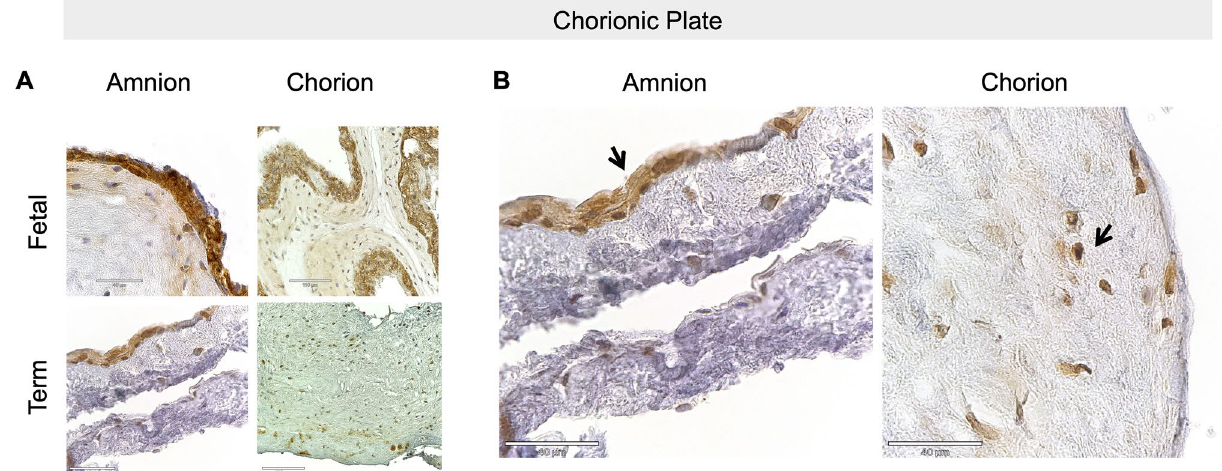
Figure 3. Fetal membranes contain RNLS. (A) RNLS labeling in amnion and chorion of the chorionic plate throughout development during fetal and term-time points. (B) Representative amnion and chorion RNLS staining with arrows pointing to regions of RNLS staining. Immunohistochemistry with hematoxylin staining for RNLS using m28-RNLS antibody at 20x (A) and 60x (B) . Black arrow pointing at RNLS positive cells.